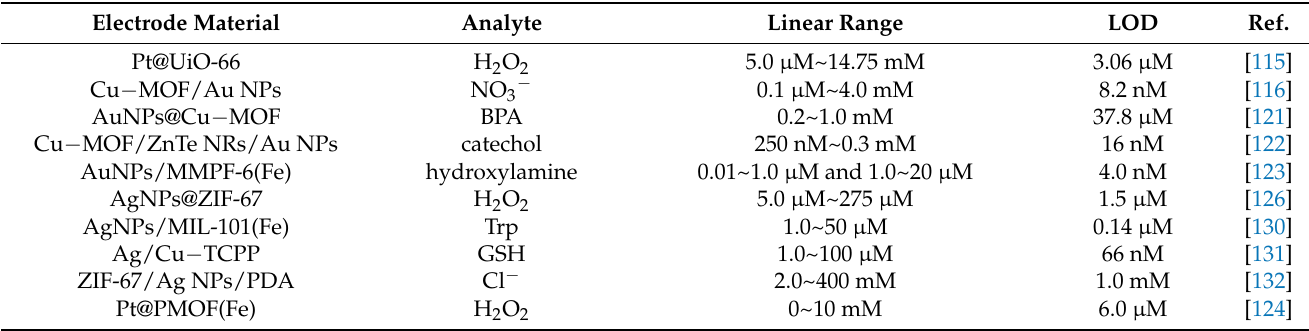
Table 3. Detection performances of different metal nanoparticle-modified MOF − based electrochemical sensors.